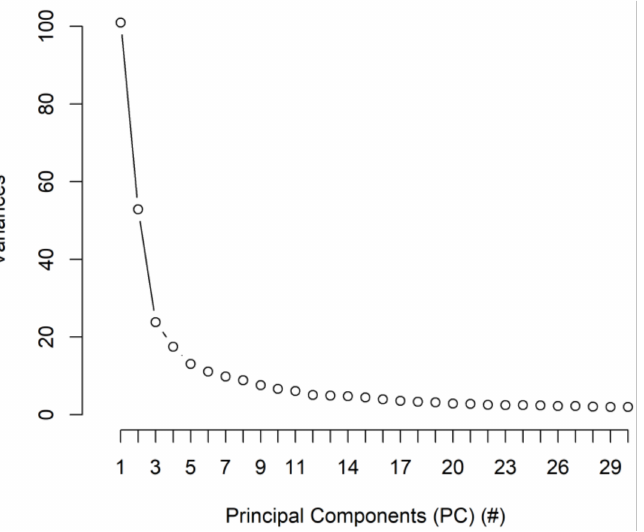
Figure 5. Scree plot used to select the number of PCs to capture a minimum of 90% variability ( n = 11). From here, the loading values for each covariate were retained for the first 11